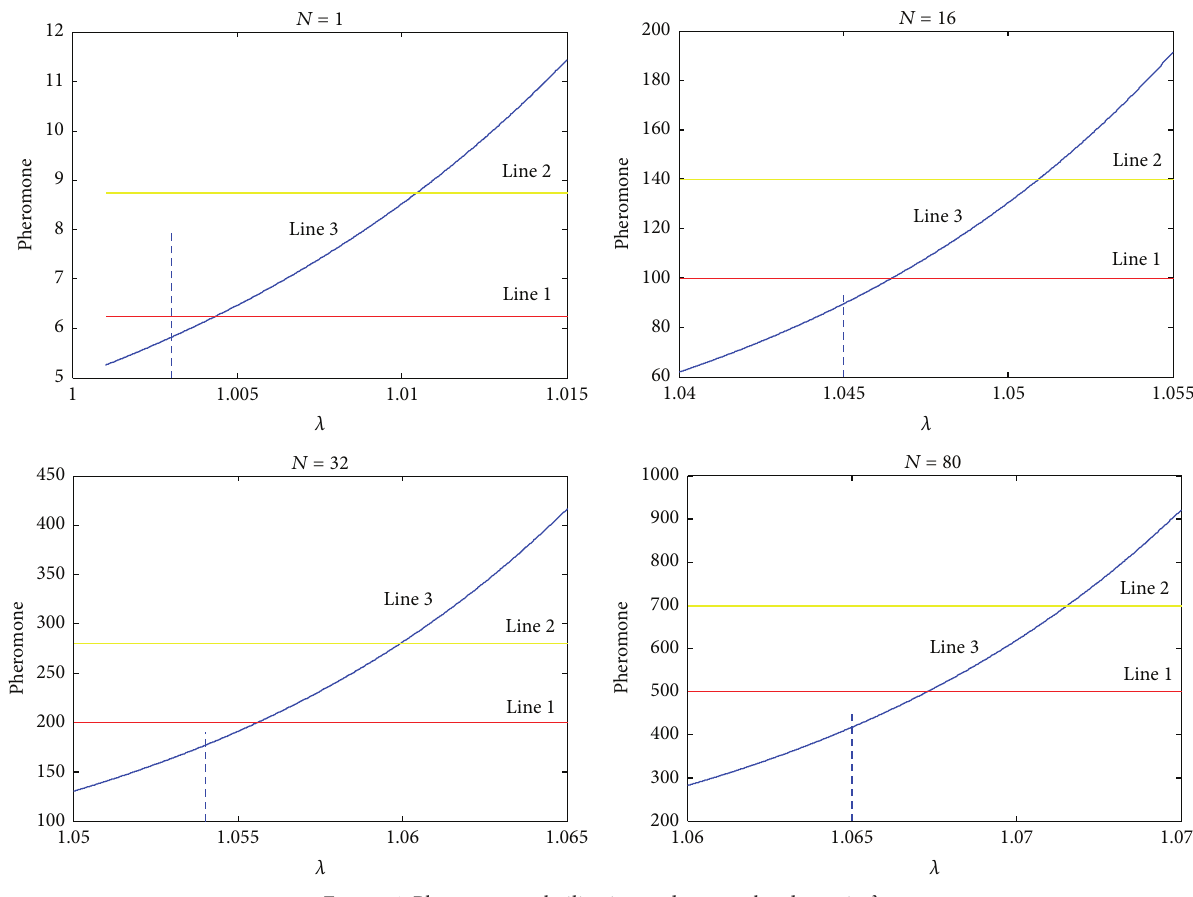
Figure 1: Pheromone volatilization and accumulated certain 𝜆